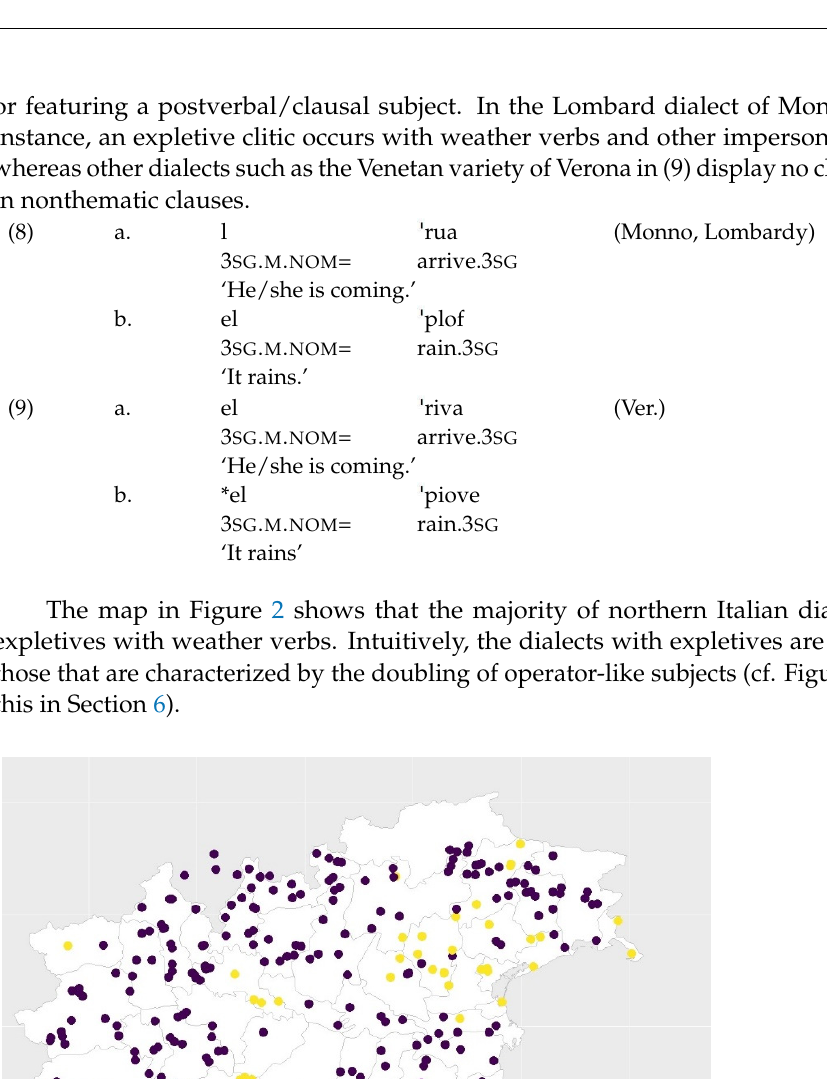
absence of expletives vs.